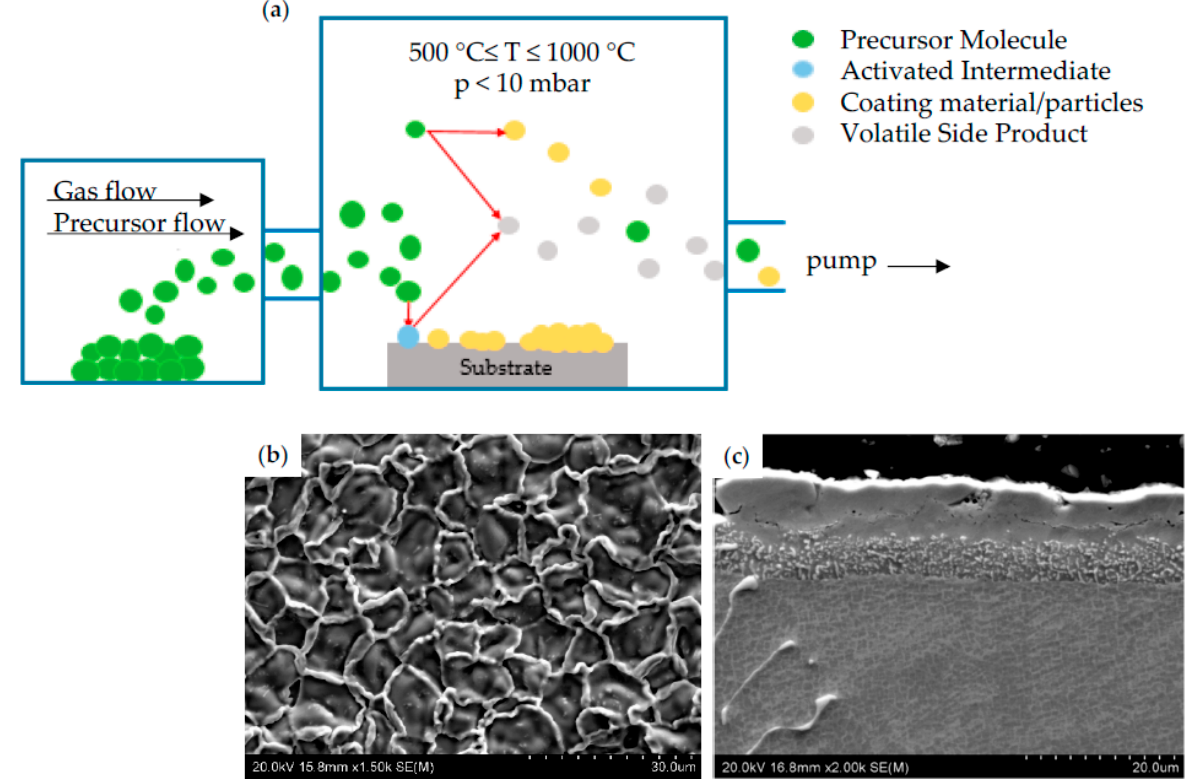
Figure 5. Schematic process of coating deposition by using CVD method ( a ); morphology ( b ) and cross-section ( c ) of CVD coating. cross-section ( c ) of CVD